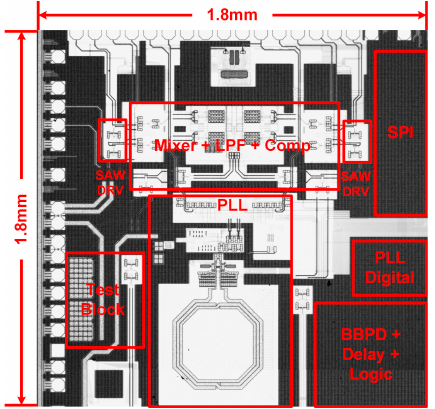
Figure 16. Readout circuit chip micrograph.